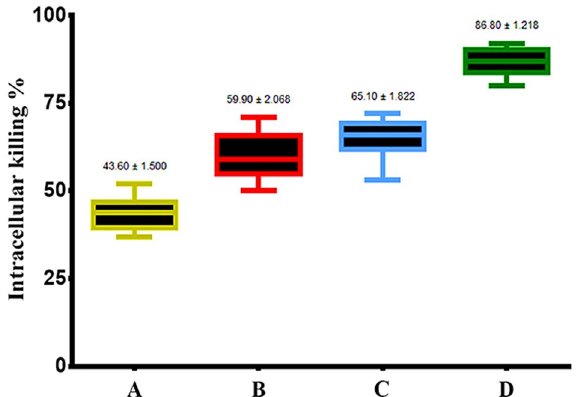
Figure 5. The prepared NPs increased the intracellular killing of E. coli by BMDMs. Data are presented as the mean ± SD. ( A ) Control BMDMs. ( B ) BMDMs treated with functionalized SWCNTs. ( C ) BMDMs treated with SWCNTs decorated with ZnO–Ag NPs. ( D ) BMDMs treated with SWCNTs decorated with ZnO–Au NPs.